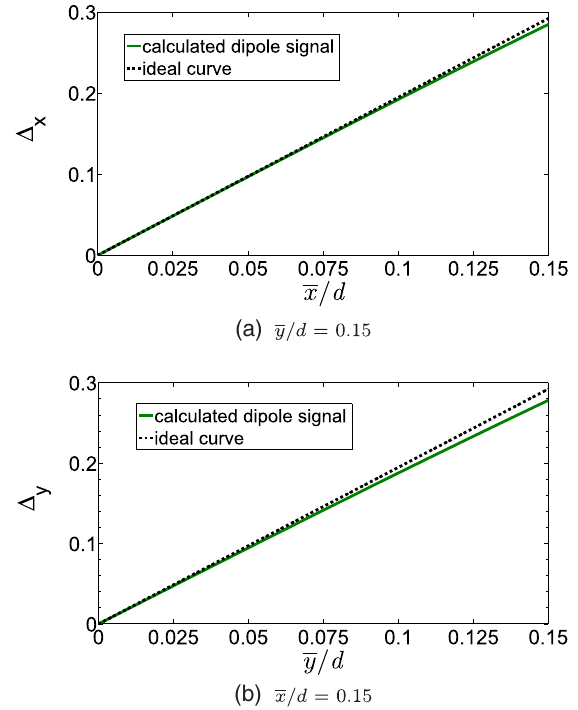
FIG. 8. Dipole signals calculated with the difference over sum method; σ x =d ¼ 0 . 15 , σ y =d ¼ 0 . 075